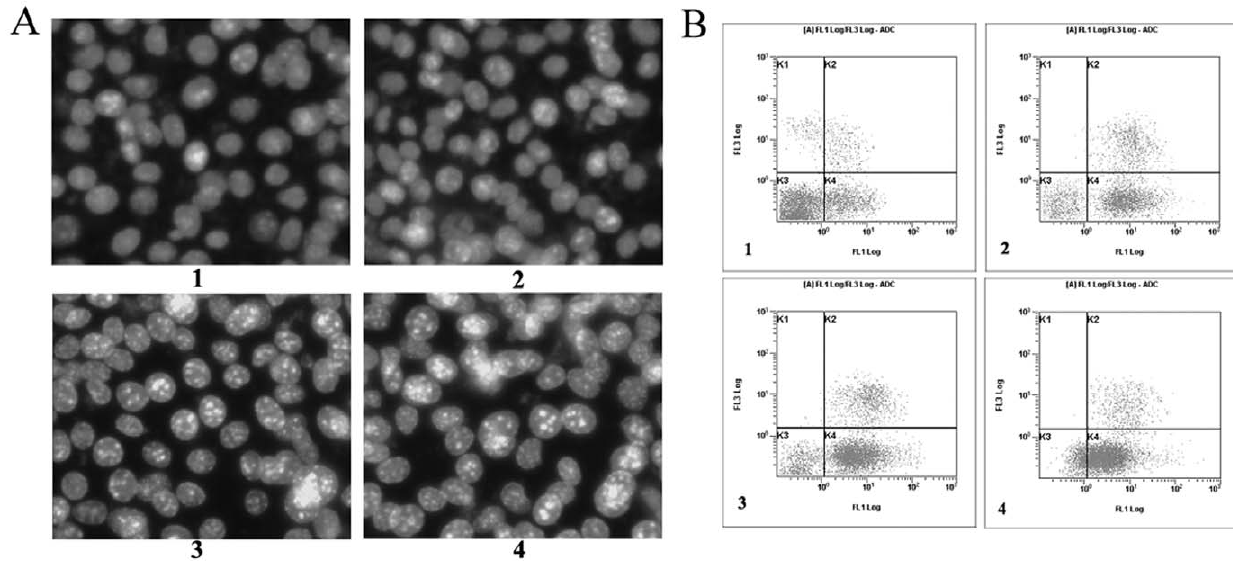
Figure 3. Apoptosis induction after 48 h treatment with fucoidan in 4T1 cells. A) Morphology of 4T1 cells observed under fluorescence microscope (Hoechst33258 6 400). DNA fragment and chromatin condensation were observed in fucoidan-treated cells, but few in untreated cells. The 50,100,200 m g/ml fucoidan treated 4T1 cells that underwent apoptosis were calculated at 18.9 6 1.17%, 42.3 6 4.38% and 67 6 7.52% respectively, while there were7.4 6 0.29% of the apoptotic cells in the control cells ( P , 0.01). B) The apoptosis cells determined by FCM. 4T1 cells were stained with annexin V-FITC and propidium iodide (PI). The lower right quadrant (annexin V + /PI 2 ) represents early apoptosis, and the upper right quadrant (annexin V + /PI + ) represents late apoptosis and necrosis. The early apoptotic rates of 4T1 cells treated with fucoidan were 24 6 1.34%, 41 6 3.75% and 59 6 5.27% respectively and significantly higher than that in control cells(11 6 0.89%) ( P , 0.05). Data are a representative of three independent experiments showing similar results. 1: control; 2: fucoidan 50 m g/ml; 3: fucoidan 100 m g/ml; 4: fucoidan 200 m g/ml.